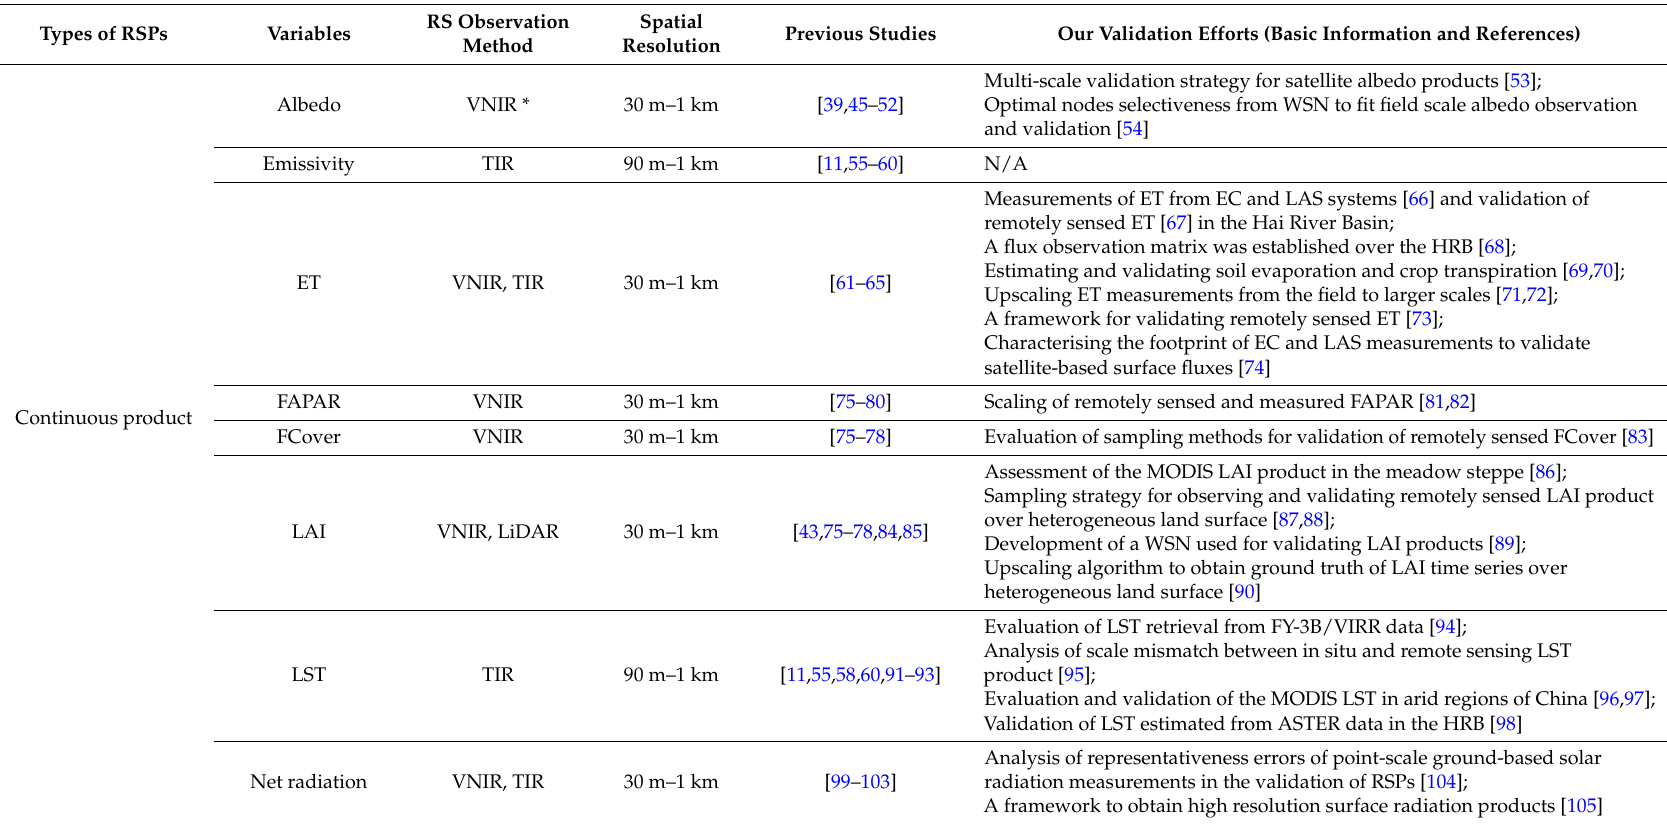
Table 1. Land surface variables to be validated. The RS observation method refers to the commonly used satellite-based